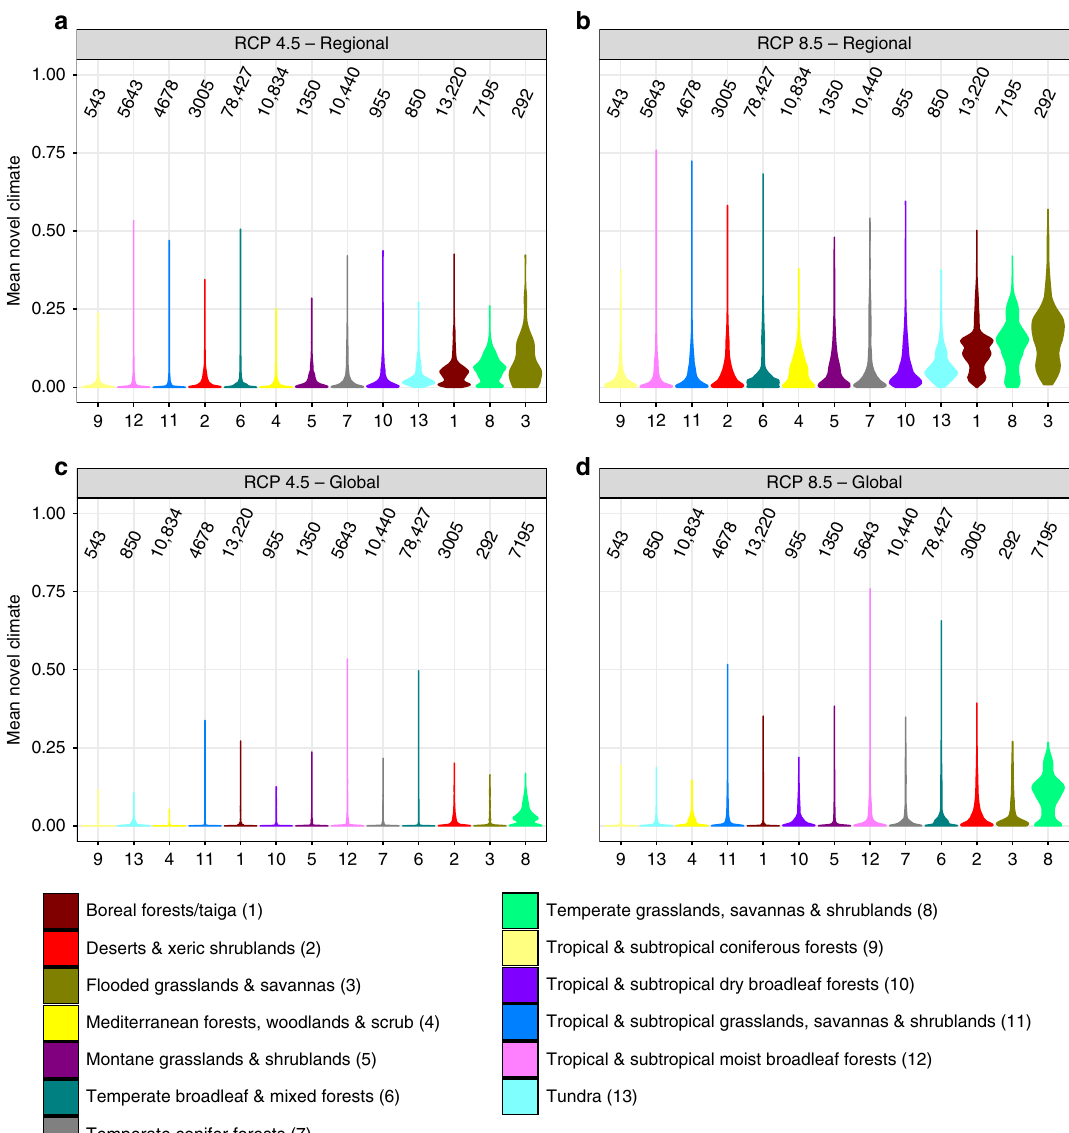
Fig. 5 Regional and global-scale novel climate index of terrestrial protected areas worldwide, summarized by biomes. The mean of the regional-scale novel climate index across ten GCMs under a RCP 4.5 and b RCP 8.5. The mean of the global-scale novel climate index across ten GCMs under c RCP 4.5 and d RCP 8.5. Violins per biome are ordered by increasing mean. Black numbers above violins indicate the number of PAs within the respective biome. Data on climate change metrics and other characteristics per PA are given as Supplementary Data 1. Source data are provided as a Source Data fi